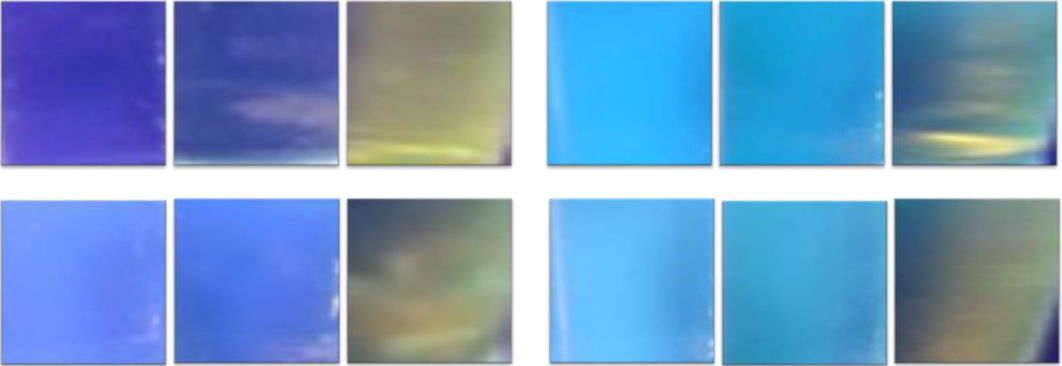
Figure 6. Visual color change (under UV light) upon gradual addition of 10 −4 M PA to 4 mL of 10 −6 M solution of compounds 1, 2, 3 and 4 in DMSO, (left, 0 μL; middle: 50 μL; right: 300 μL).